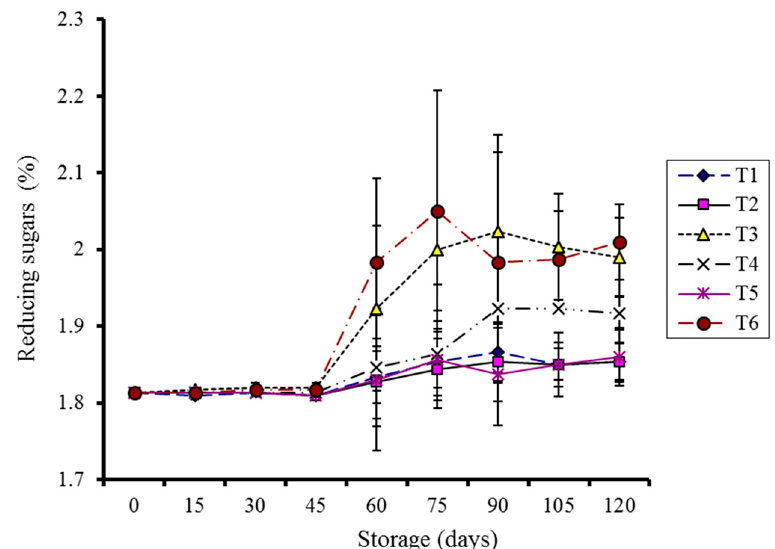
Figure 6. Effect of CMC and guargum-based silver nanoparticle coatings on the reducing sugars of kinnow fruit stored at 4 and 10 °C during storage. The vertical bars represent standard error of the means. Values represented as mean ± SE of three replicates.